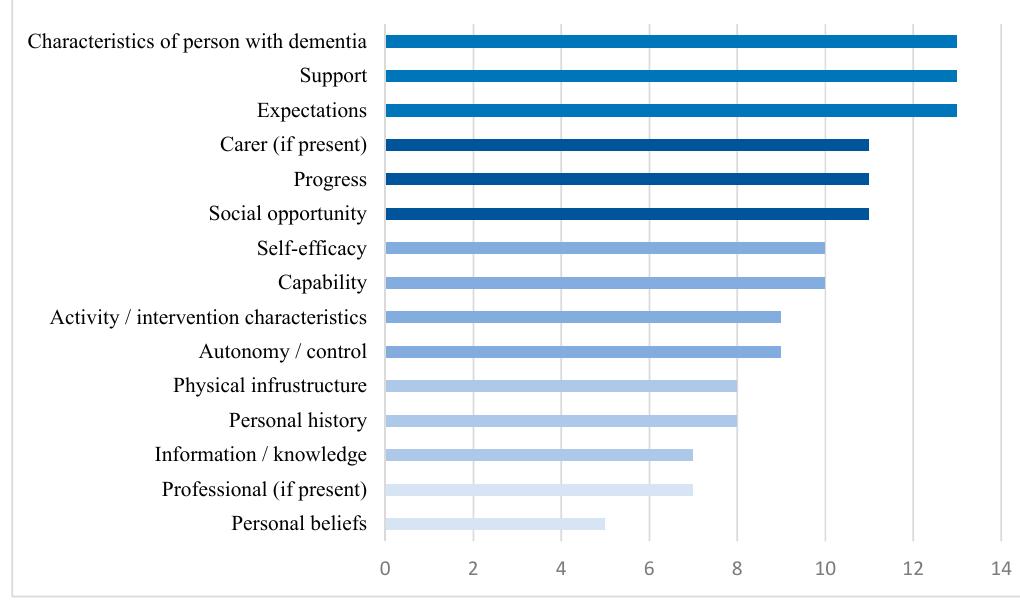
Figure 2. Frequency of constructs in the interviews (n).